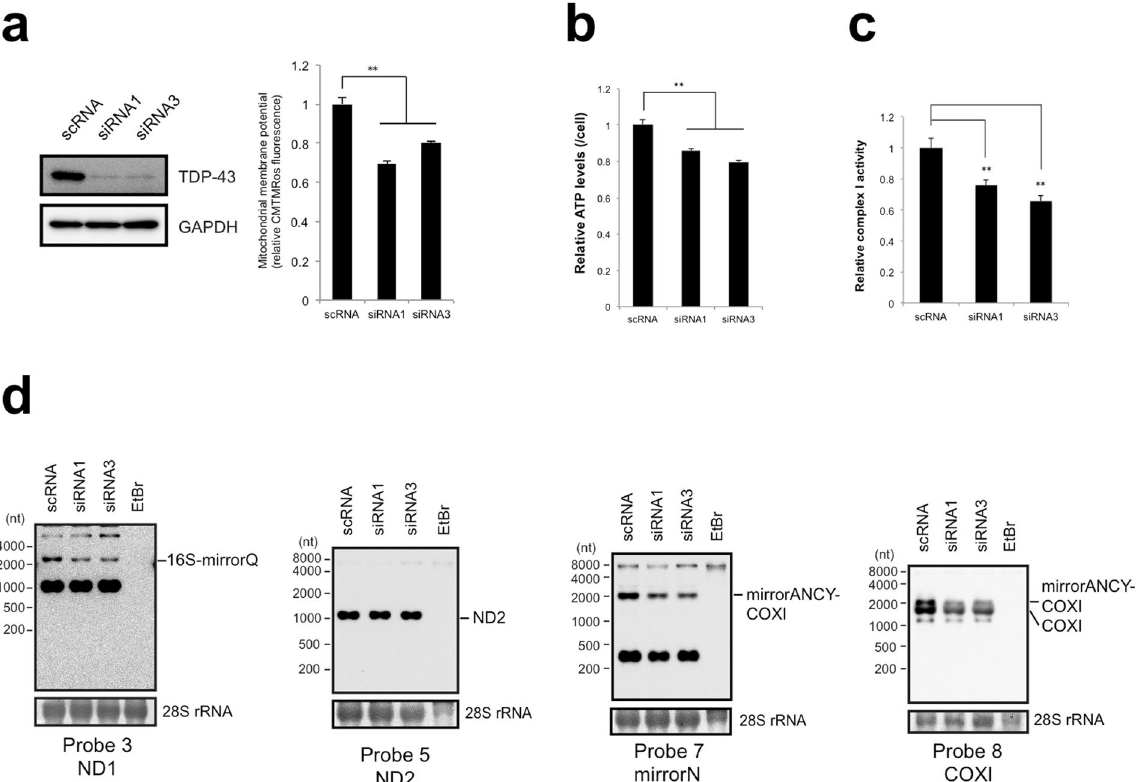
Figure 7. TDP-43 deficiency impairs mitochondrial function and decreases intermediates of mitochondrial transcripts. ( a ) Mitochondrial membrane potential was measured by CMTMRos staining of MCF7 cells after knockdown of TDP-43 with siRNA1 or siRNA3. The membrane potential per concentration of total proteins of the siRNA-treated cells relative to that for scRNA-treated cells harvested at 72 h after treatment is shown. Values are the average ± SD of five independent experiments. ** P < 0.01 (unpaired t test). TDP-43 level was examined by western blotting with the indicated antibodies. ( b ) Cellular ATP levels per siRNA-treated MCF7 cell were calculated relative to that for scRNA-treated cells. Values are the average ± SD of six independent experiments. ** P < 0.01 (unpaired t test). ( c ) Activity of electron transfer complex I per concentration of total proteins was measured for MCF7 cells harvested at 72 h after siRNA treatment relative to that measured for MCF7 cells with scRNA treatment. Values are the average ± SD of three independent experiments. ** P < 0.01. ( d ) mt-tRNA levels upon knockdown of TDP-43 in MCF7 cells were assessed with northern blotting. Probes are indicated under the figures. The intermediates of mitochondrial transcripts were indicated to the right side of the figures. 28S rRNA stained by methylene blue served as a loading